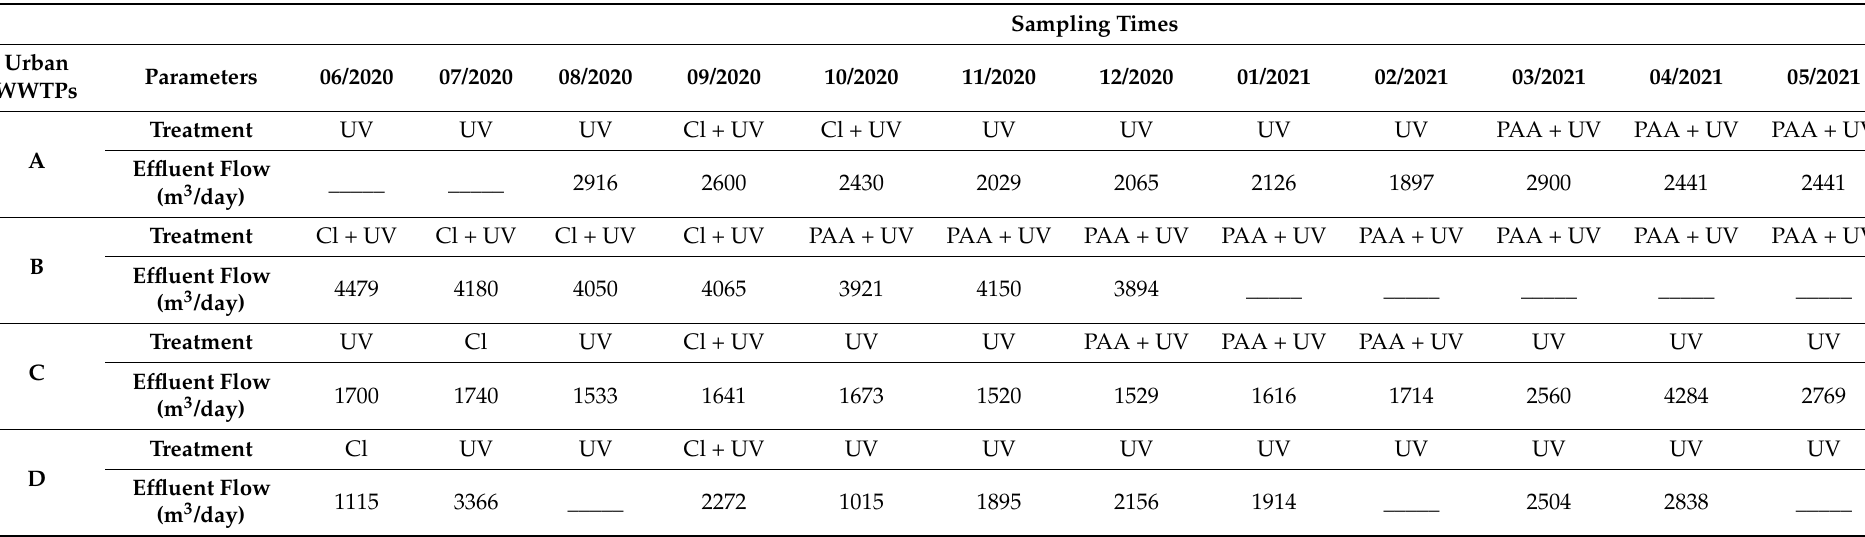
Table 1. Urban wastewater Treatment Plants (WWTPs), sampling times, treated effluent flow and disinfection system: chlorine, peracetic acid (PAA), ultraviolet radiation